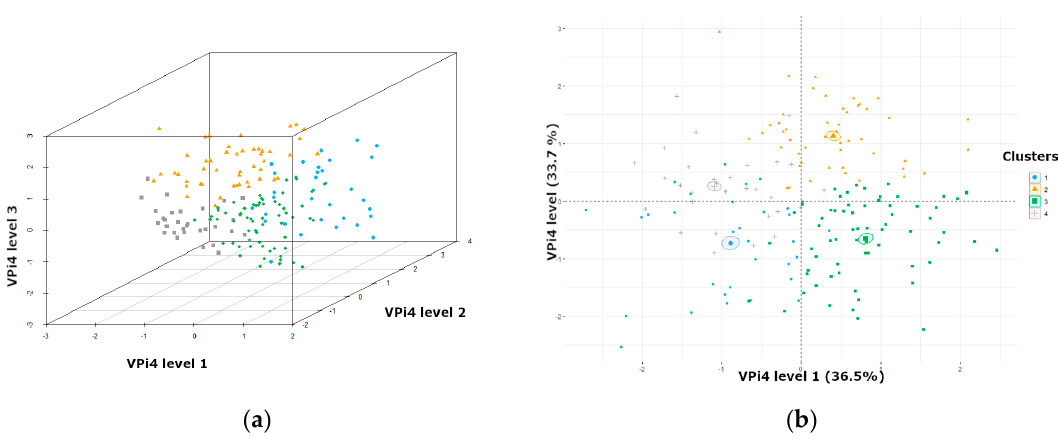
Figure 2. K-means and PCA analysis results: ( a ) clusters based on three factors (i.e., F1, F2, and F3) in 3D space; ( b ) biplot—PCA combined with cluster analysis (relations of the clusters and factors).